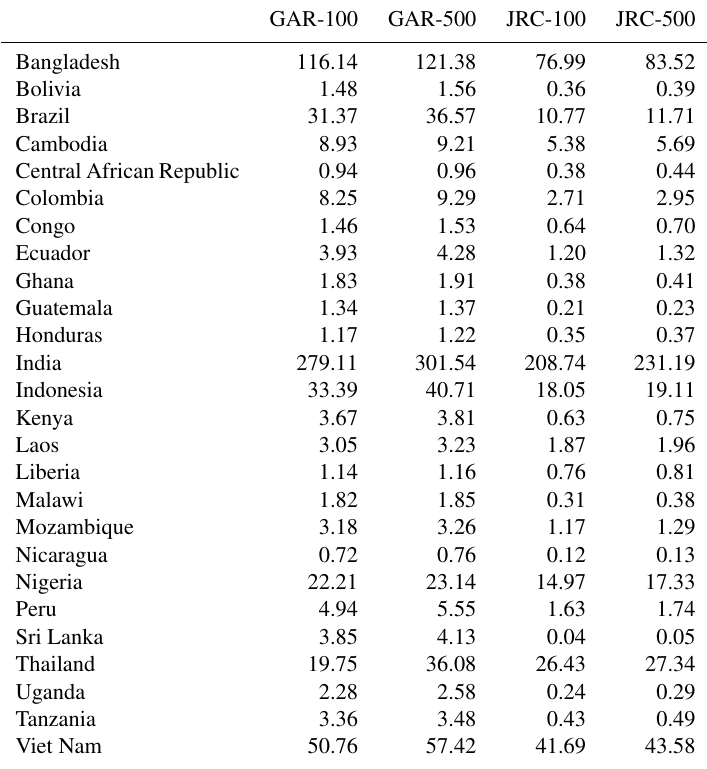
Table A10. Population estimates within flood-prone areas (millions) using a return period of 100 years compared to 500 years, intersecting GAR and JRC with the HRSL population